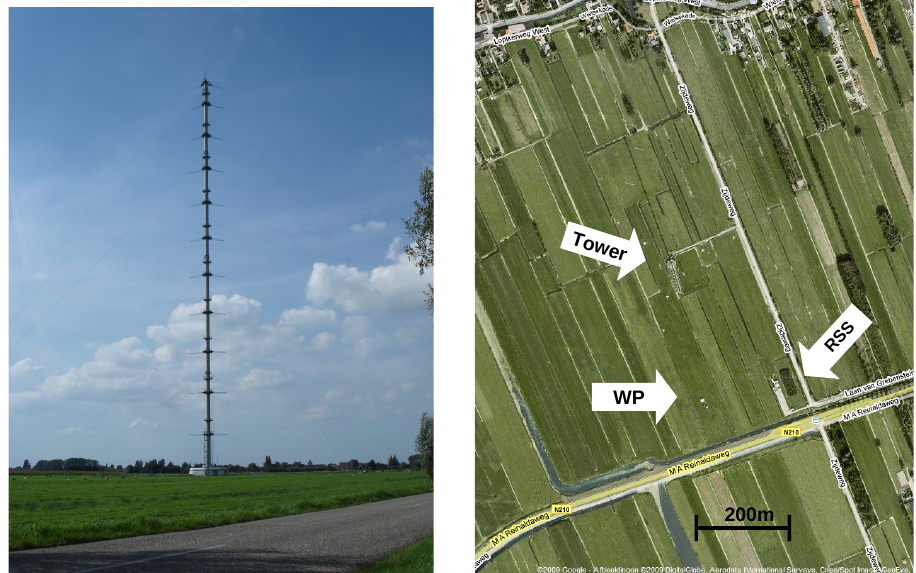
Fig. 1. Left panel: the 213m tall meteorological tower at the CESAR site, Cabauw, The Netherlands (source: Wikipedia, http://nl.wikipedia. org/wiki/Meetmast Cabauw). Right panel: aerial view of the CESAR site at Cabauw depicting the grassland polder landscape, a nearby village to the North, and a local secondary road to the South. Here “RSS” indicates the remote sensing site and “WP” the wind profiler site. Image orientation is north-south hence nearby “Zijdeweg” runs at 23 ◦ away from due north. Depicted area measures 900 × 1100m 2 (source: Google Maps, http://maps.google.nl).